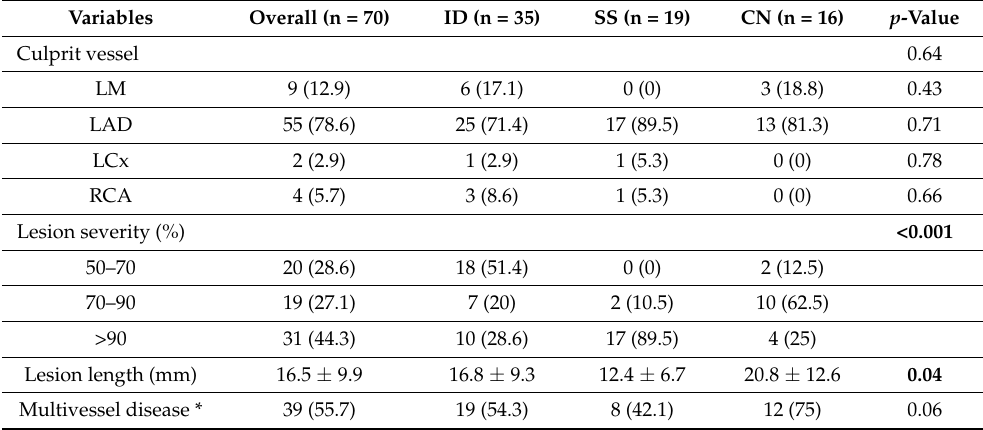
Table 3. Angiographic